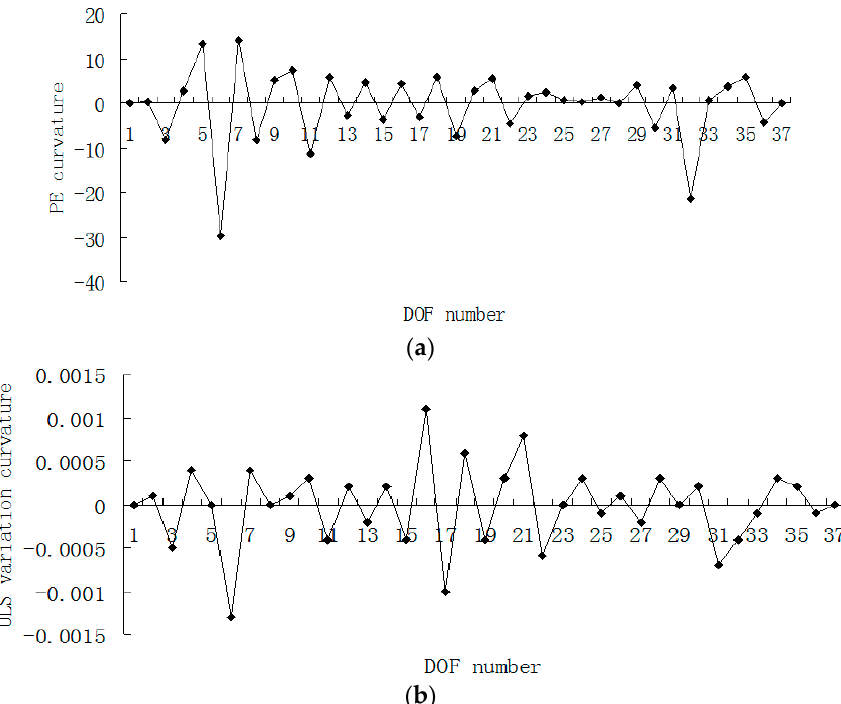
Figure 14. ( a ) Damage index (PE curvature) map using the first four modes with 3% noise when elements 5 and 31 are damaged; ( b ) Damage index (ULS variation curvature) map using the first four modes with 3% noise when elements 5 and 31 are damaged (×10 − 3 ).